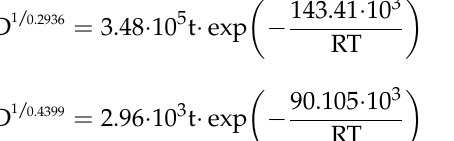
( b ) Figure 8. The correlation between the calculated and experimental values of iron particle size after the carbothermic reduction of RM without additives ( a ) and with 13.65% Na 2 SO 4 ( b ).